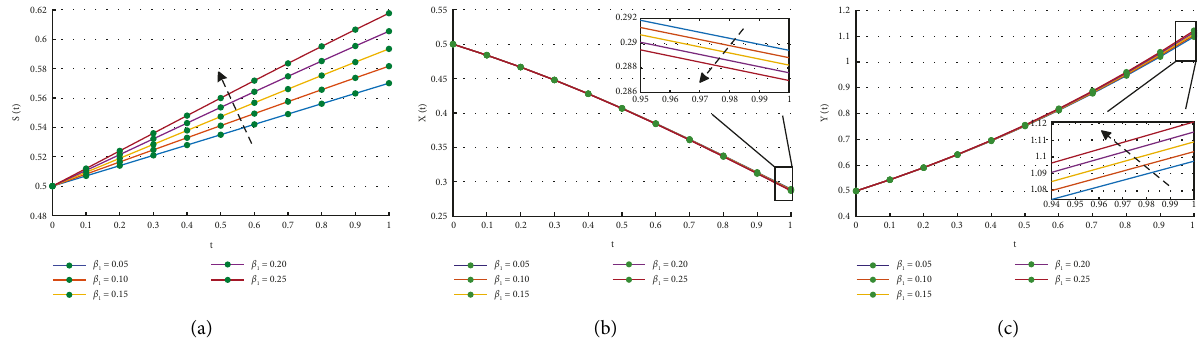
on population 1